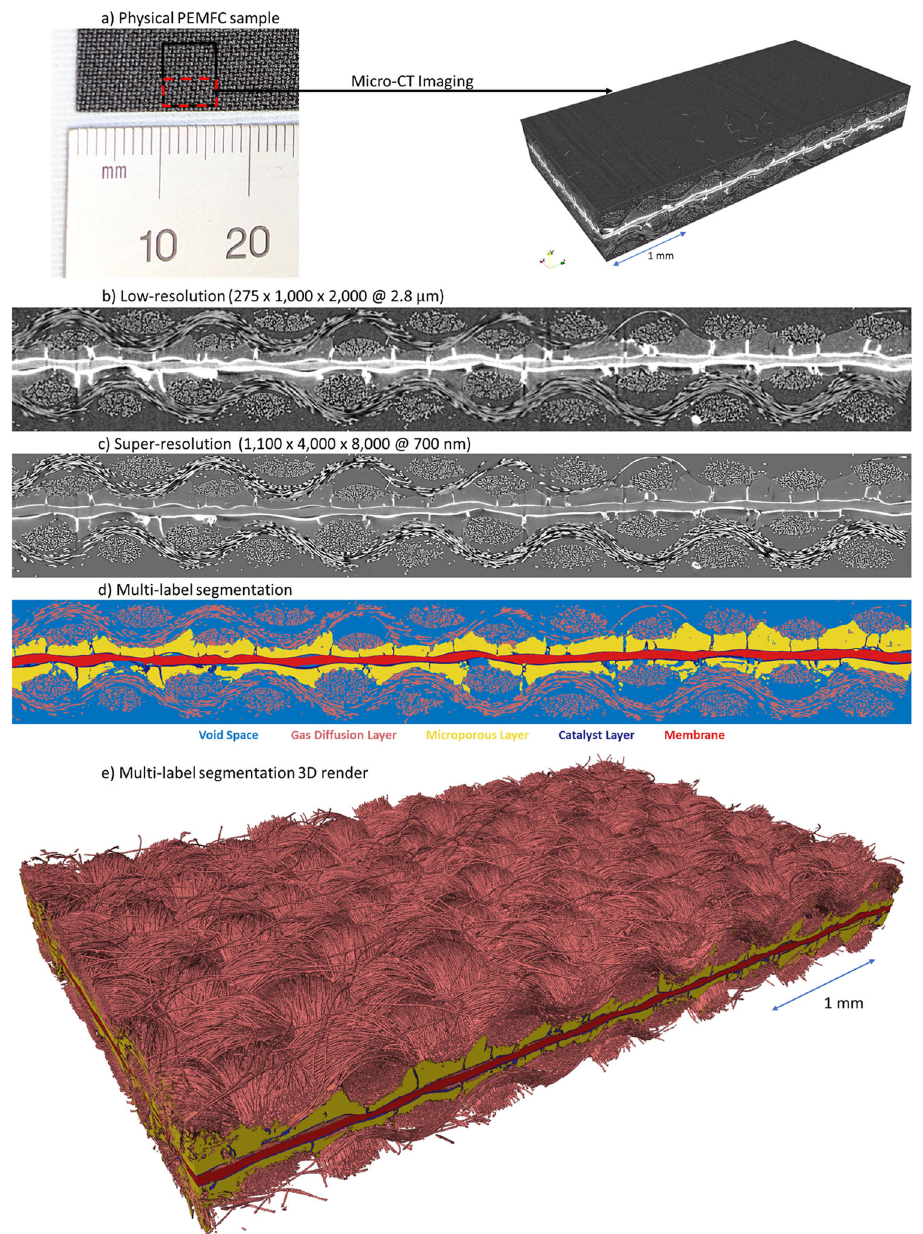
Fig. 2 | Micro-CT imaging, deep learned super-resolution and multi-label seg- mentation.a Photographandmicro-CTimageofthePEMFCphysicalsample. b 2D cross section of the low-resolution (275×1000×2000 at 2.8 μ m) for comparison